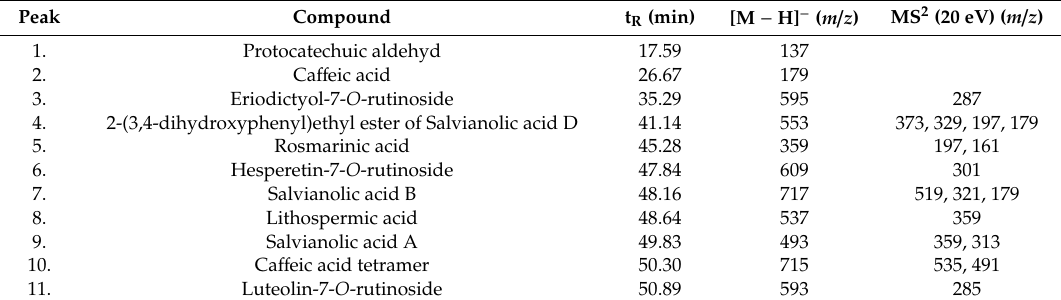
Table 1. Polar phenolic compounds in infusions of Mentha rhizomes, their corresponding retention times (t R ), molecular ions [M − H], and MS 2 fragments in LC-MS analysis. Peak